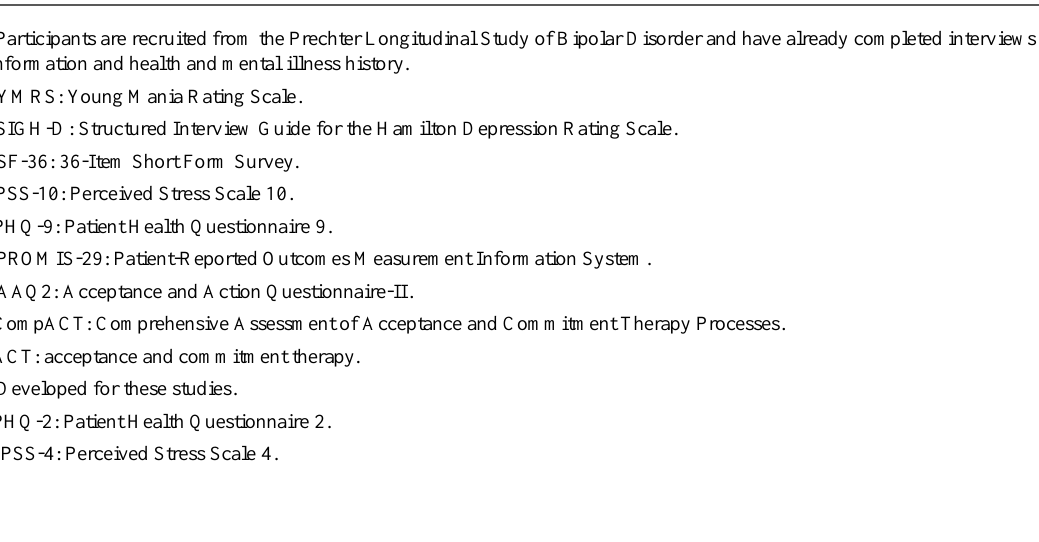
College student cohortBipolar cohortDesign